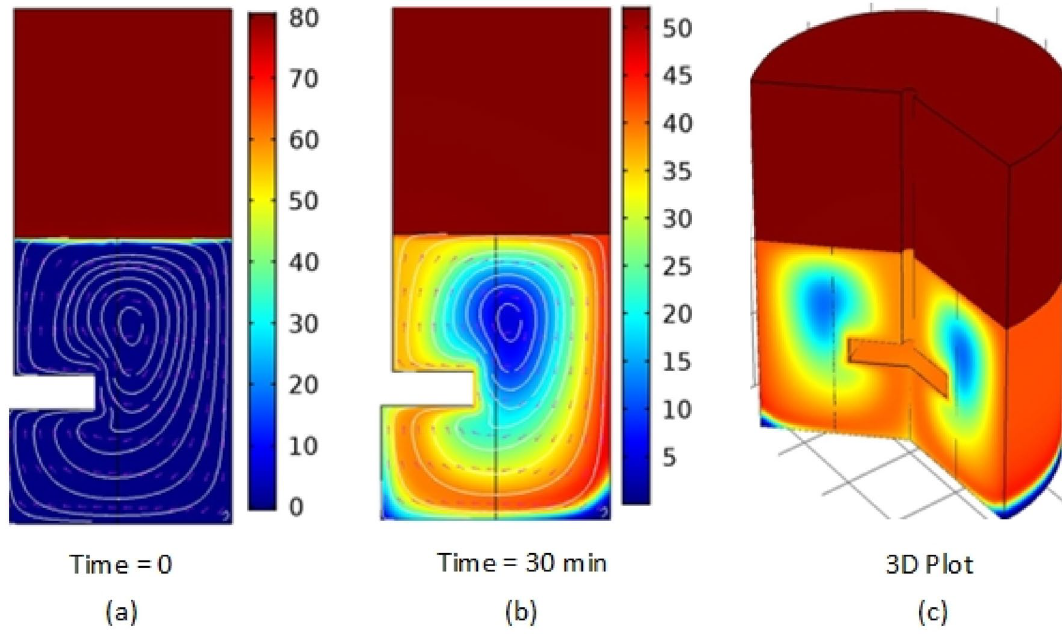
Figure 4. CO 2 concentration (mol/m 3 ) profile in pure water versus time in a high pressure stirred cell. The pressure is atmospheric; temperature is 24 °C; initial CO 2 concentration is 80 mol/m 3 ; the particle diameter is